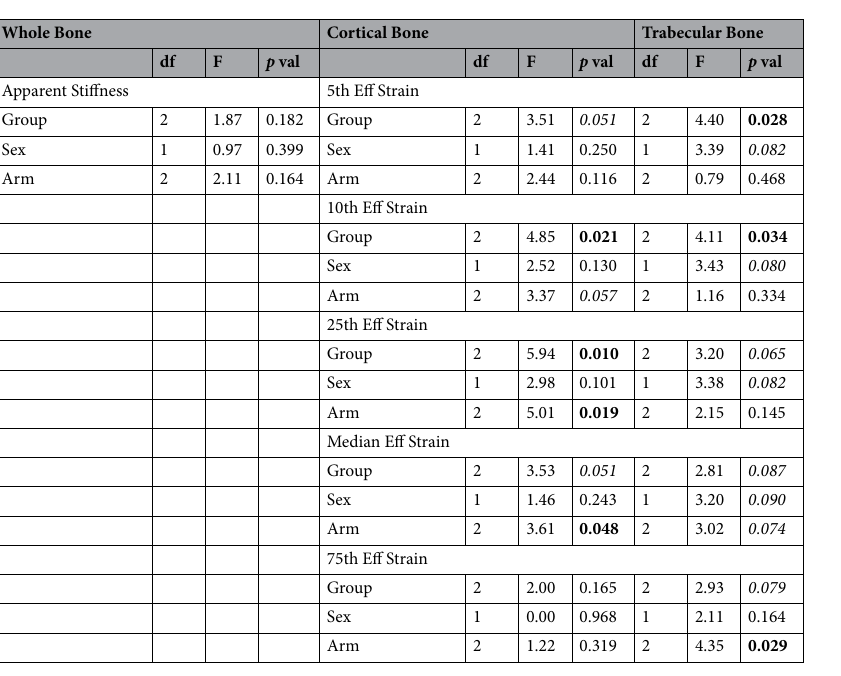
Table 5. ANCOVA summary for mechanical parameters. Cortical and trabecular effective (Eff) strain values reported for 5th, 10th, 25th, median, and 75th percentiles. p values represent contrast differences as assessed by Tukey’s HSD method. p values in bold are significant and those in italic are considered near significant, with significant contrasts detected during post hoc testing.